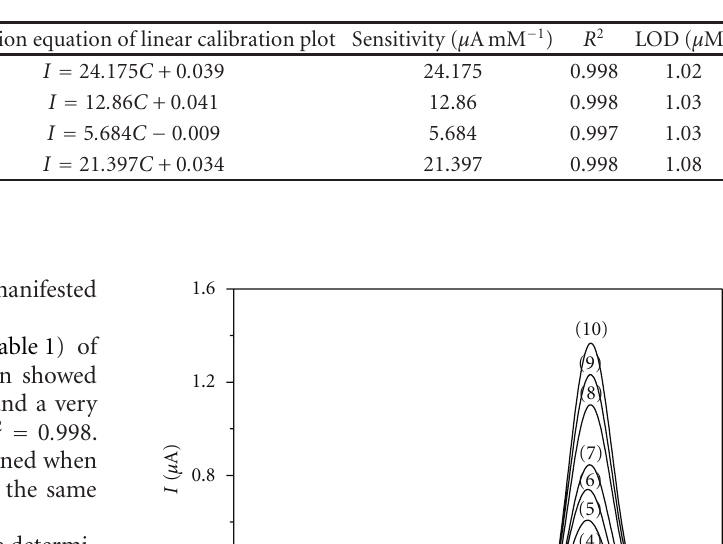
Table 1: Parameters of calibration plots ( I = aC + b ; I ( μ A); a ( μ AmM − 1 ); C (mM); b ( μ A)), determination coe ffi cient, and LOD values for acetylsalicylic acid (ASA) determination using CV, DPV, and CA methods.